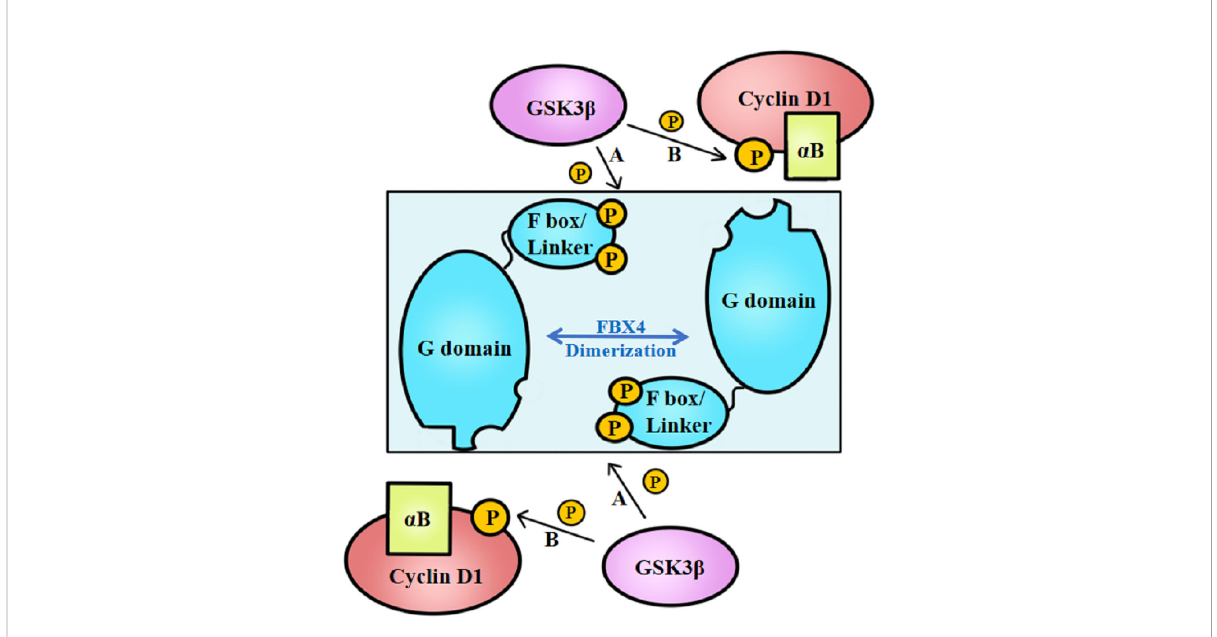
FIGURE 3 GSK3 b -mediated FBX4 and cyclin D1 phosphorylation. (A) GSK3 b phosphorylates FBX4 at Ser8 and Ser 12 of F box domain. (B) GSK3 b phosphorylates cyclin D1 at Thr286. a B, alpha